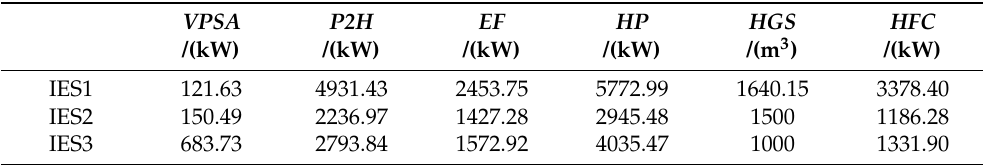
Table 8. Equipment planned capacity.